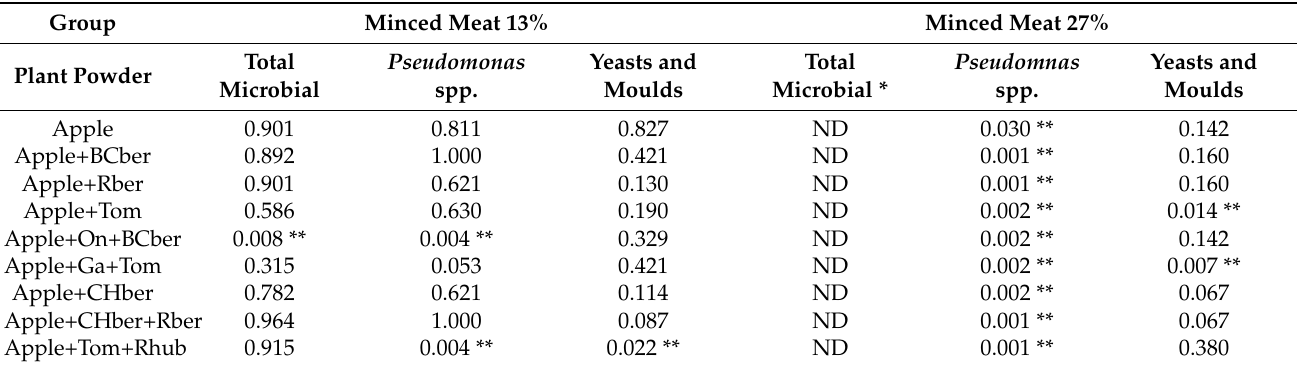
Table 3. p -values of differences in microbial counts between minced meat controls (13% and 27% fat content) and minced meat samples with added plant powders on 5, 7, 9, and 12 storage days